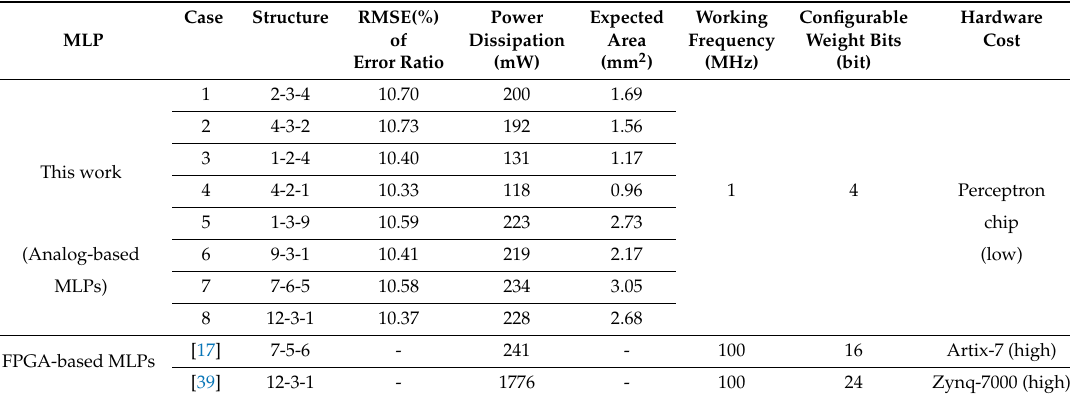
Table 3. Analog-based MLPs and comparision to FPGA-based MLPs with same